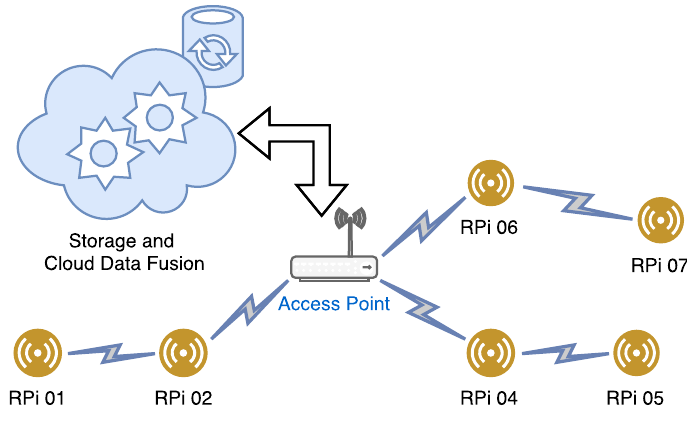
Figure 2. Partial mesh network implemented in our